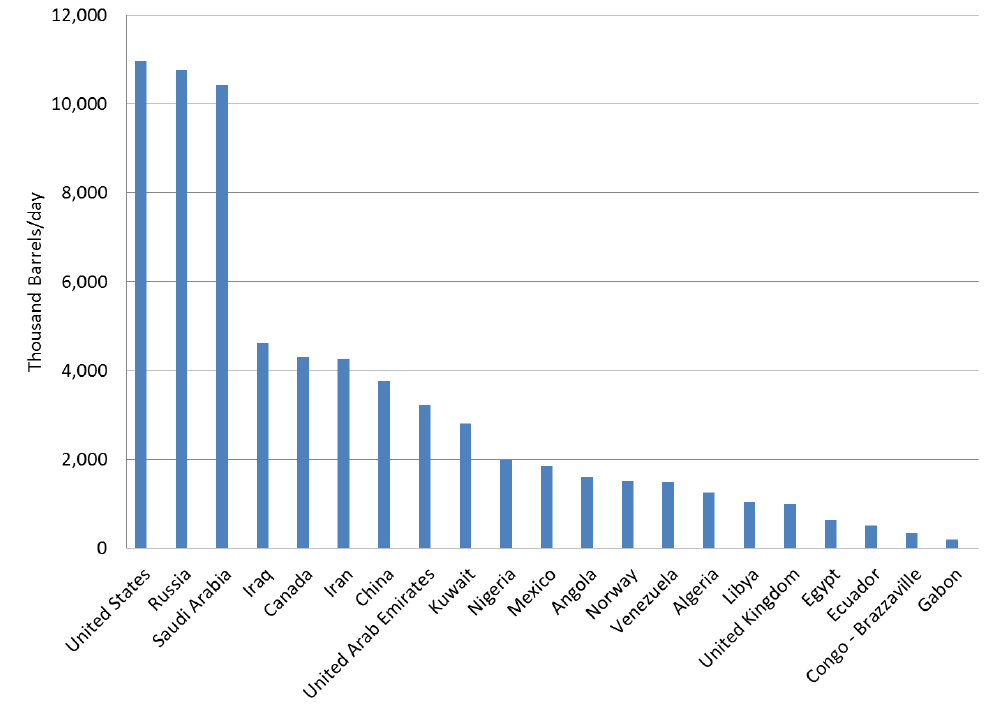
Figure 2. Major crude oil producing countries by production volume in 2018. Data source: U.S. Energy Information Administration [6].